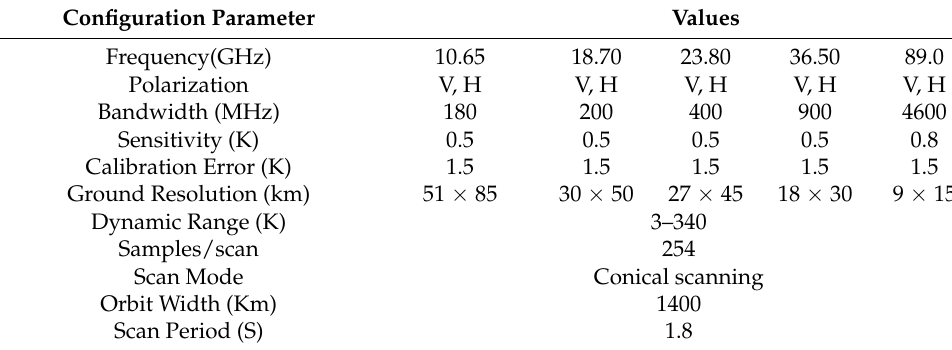
Table 1. Specifications of the MWRI